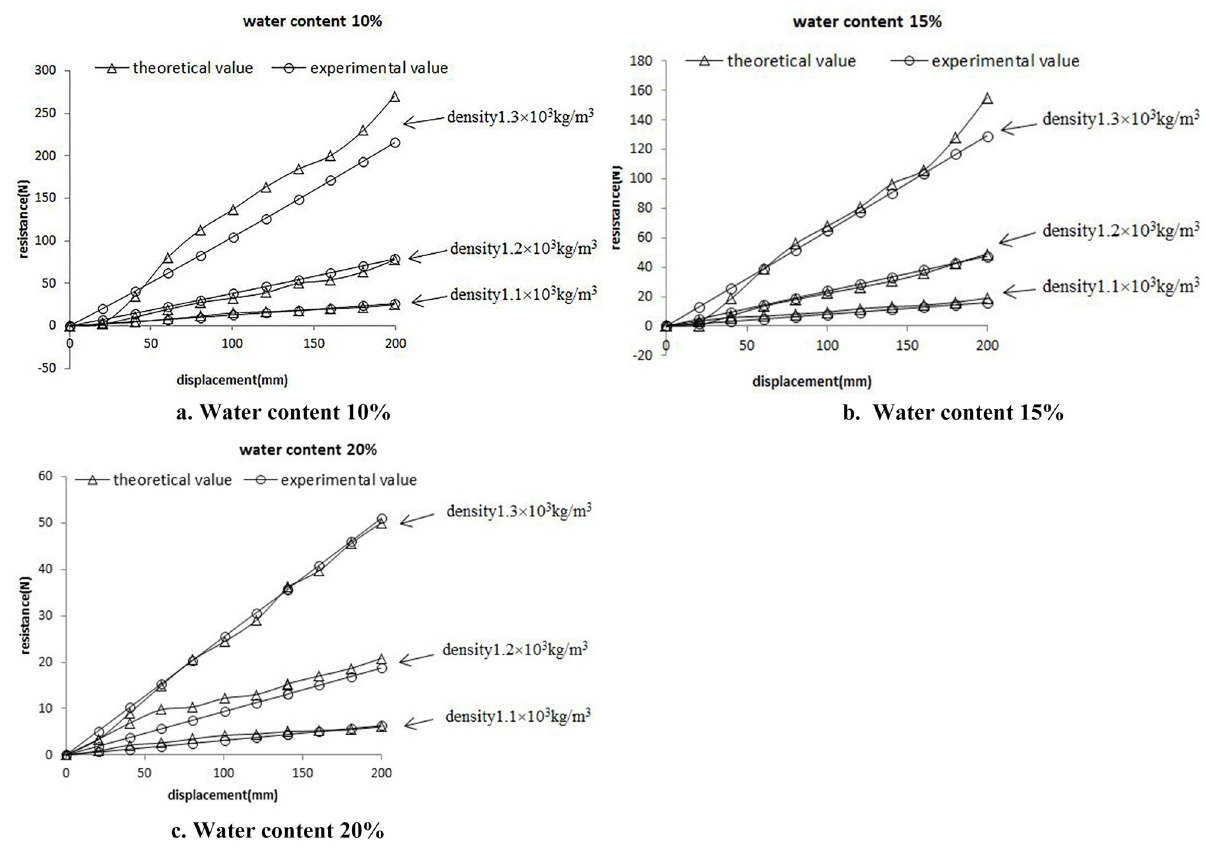
Fig 5. Comparison of theoretical resistance and experimental